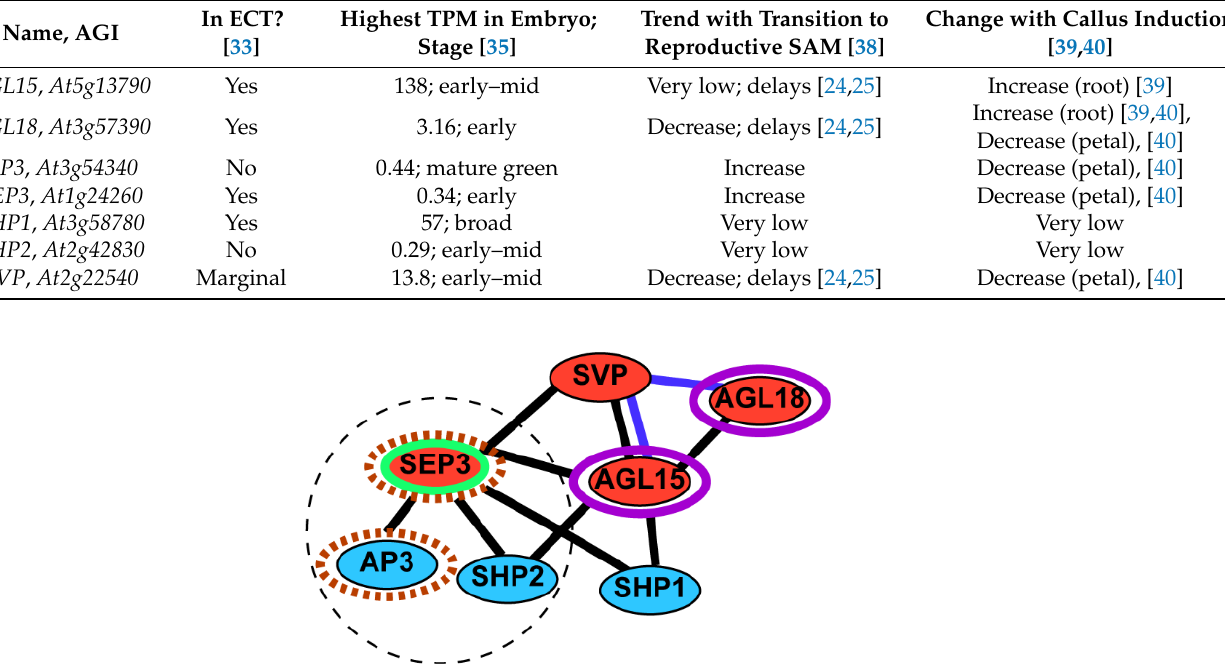
Figure 5. Interactions among MADS-proteins in this study. Lines connecting MADS indicate evidence of physical (black) and/or genetic (blue) interactions as complied in BioGRID. Red indicates the presence of and EAR/LxLxL motif in the protein. The green outline on SEP3 indicates evidence for transactivation activity [32]. The purple outline highlights MADS associated with embryo development, decreased transcript accumulation with the transition to reproductive development and increased transcript accumulation with dedifferentiation on callus-inducing medium as summarized in Table 1. Brown dotted outlines indicate the opposite pattern. The black dotted circle highlights the subset of genes studied that respond to AGL15-VP16.